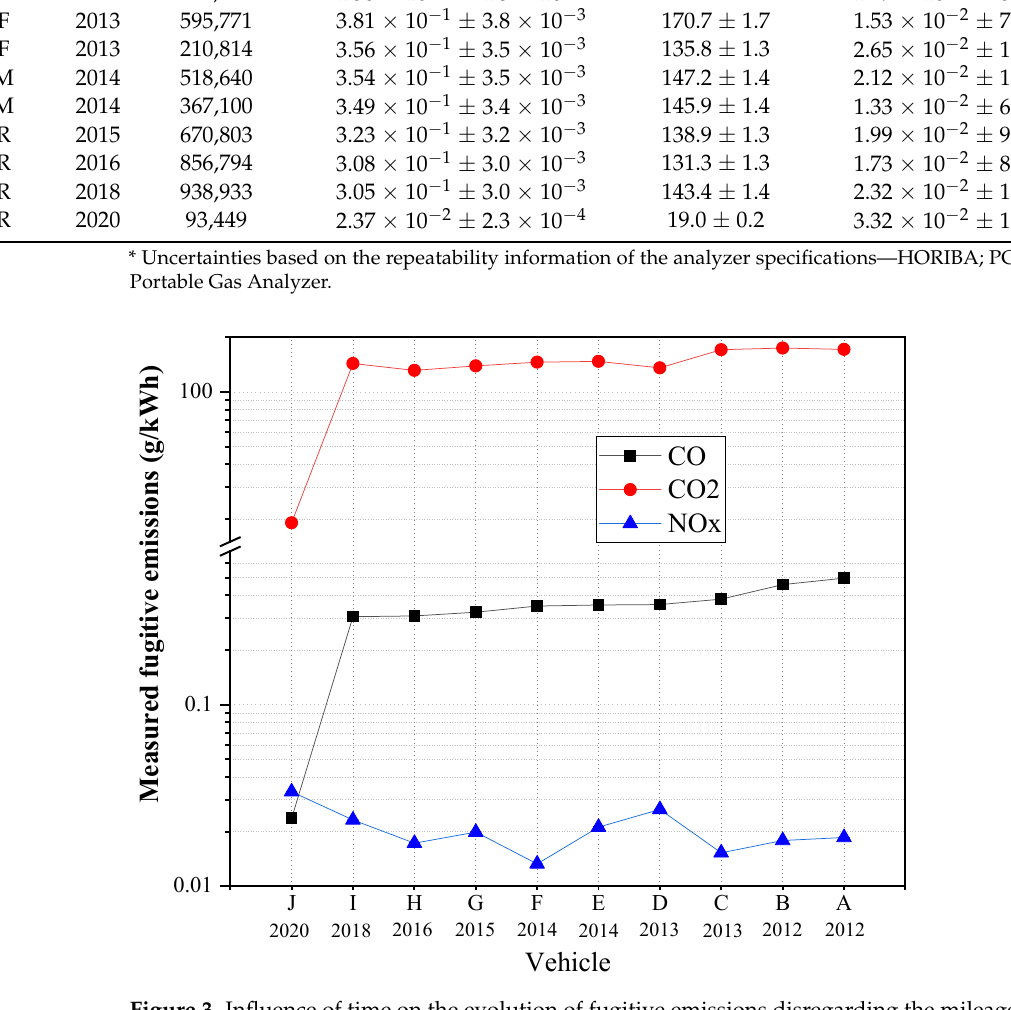
Figure 3. Influence of time on the evolution of fugitive emissions disregarding the mileage